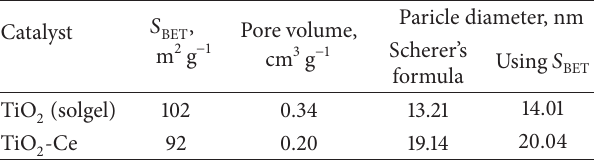
Table 1: Physical characterization of the